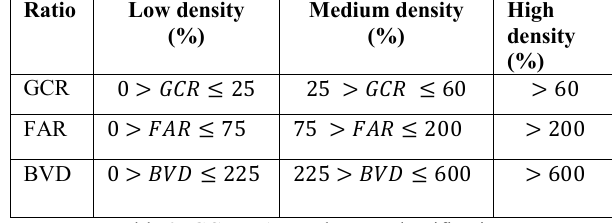
Table 3: GCR, FAR and BVD